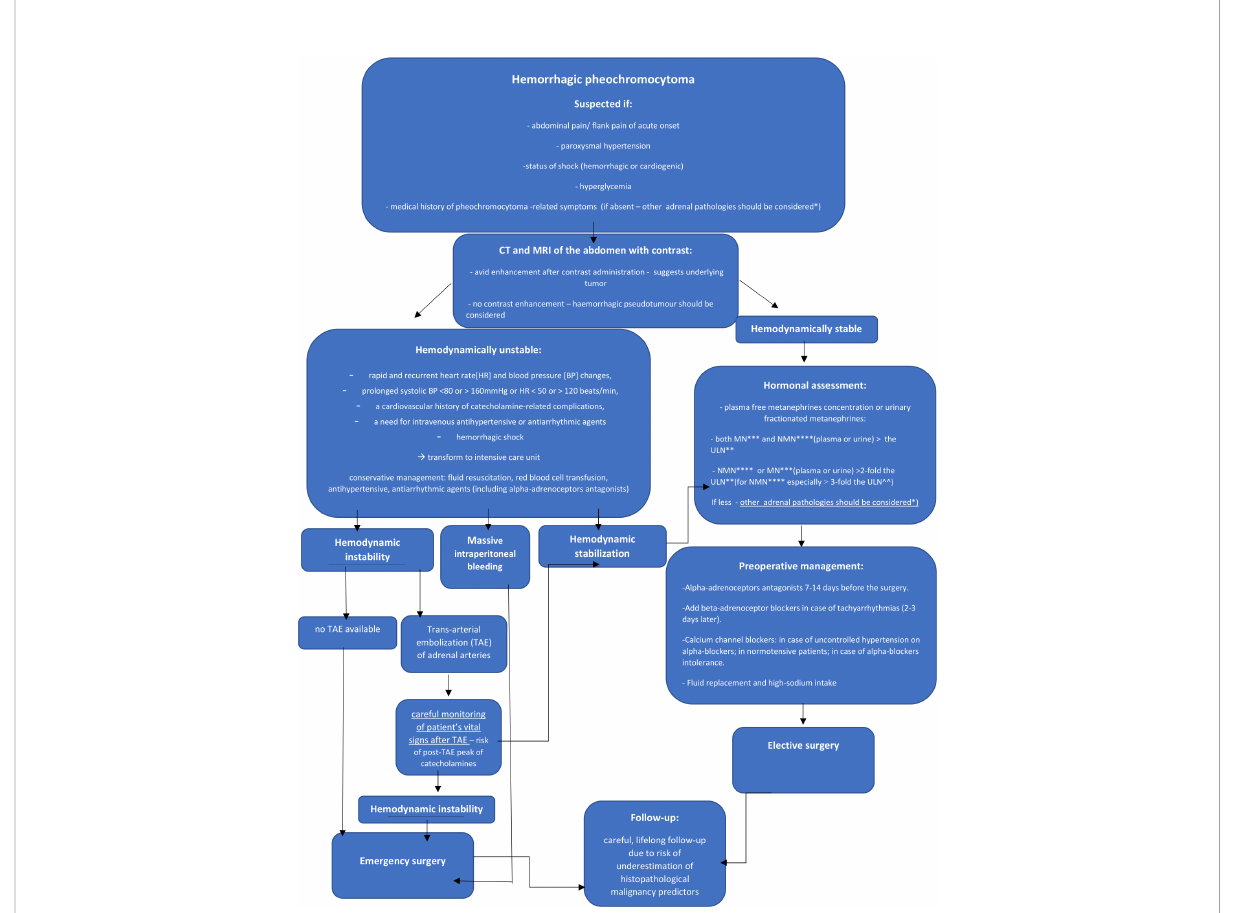
FIGURE 11 Algorithm for the diagnosis and treatment of adrenal hemorrhage in the course of pheochromocytoma. *mainly hemorrhagic pseudotumour, metastases, myelolipoma, primary adrenocortical carcinoma ** The upper limit of normal ***